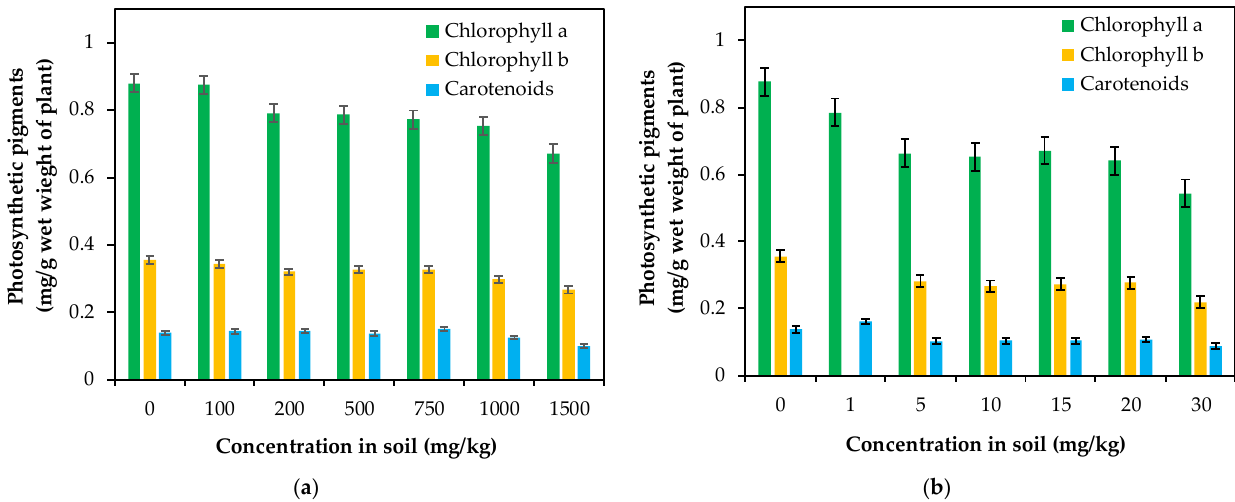
Figure 8. ( a ) Lead and ( b ) cadmium effects on the contents of photosynthetic pigments. Error bars indicate mean ± SD.